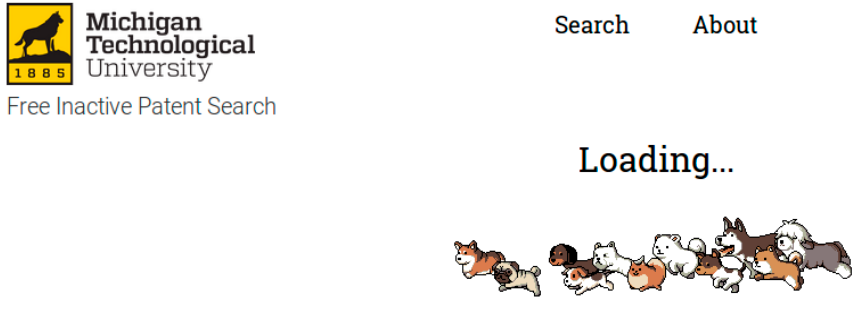
Figure 2. Loading page.